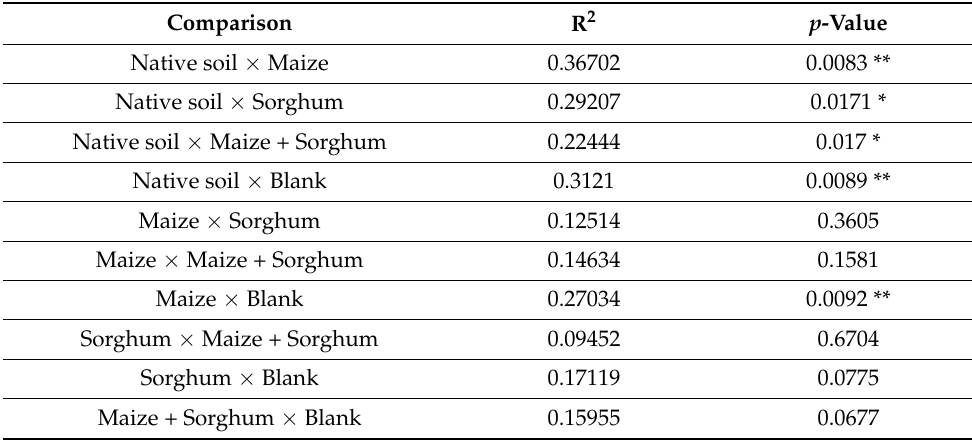
Table 2. Comparison of T-RF components in trap culture under different host plants. Comparison was performed by pairwise PERMANOVA of Jaccard distances.